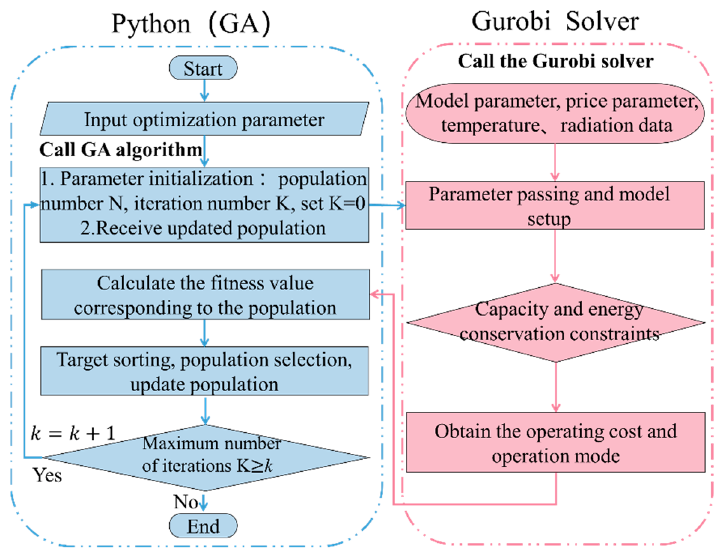
Figure 3. Solution flow chart of the bi-level optimization